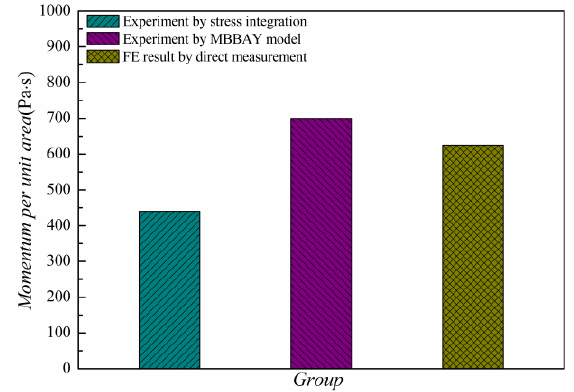
Figure 6. Blow-off impulse (BOI) momentum by experiment and our FE model.